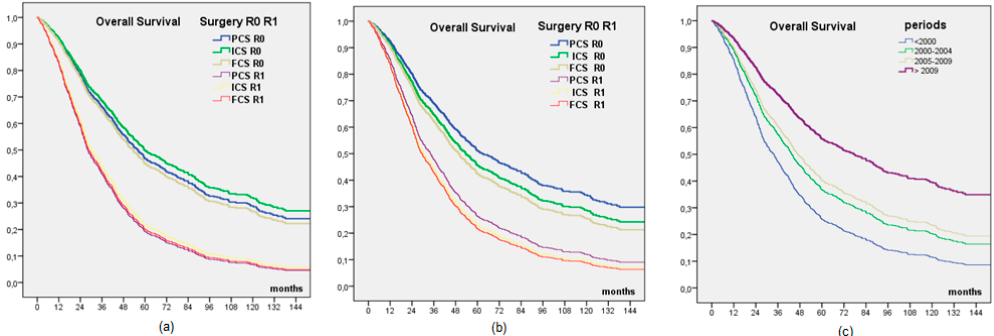
Figure 1. Multivariate analysis after adjustment for the prognostic factors; ( a ): overall survival depending on time of surgery and residual disease; ( b ): Cox model adjusted on periods; ( c ): overall survival depending on time periods. Table 4. Factors influencing Overall Survival (OS) and PFS among R0 patients. (a) Factors influencing overall survival among R0 patients. (b) Factors influencing progression free survival among R0 patients.